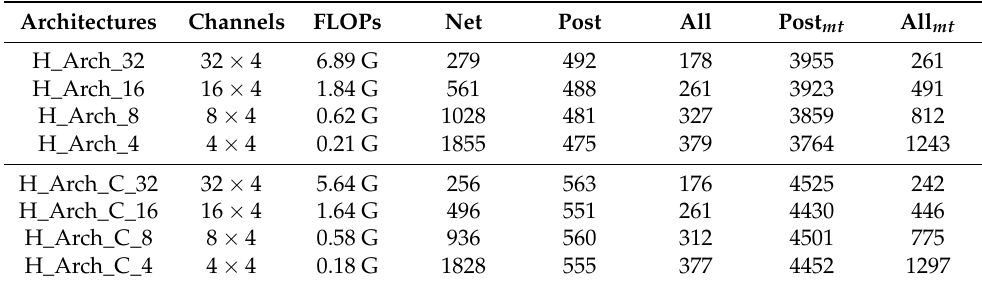
Table 7. Computation efficiency in FPS (HRSID).